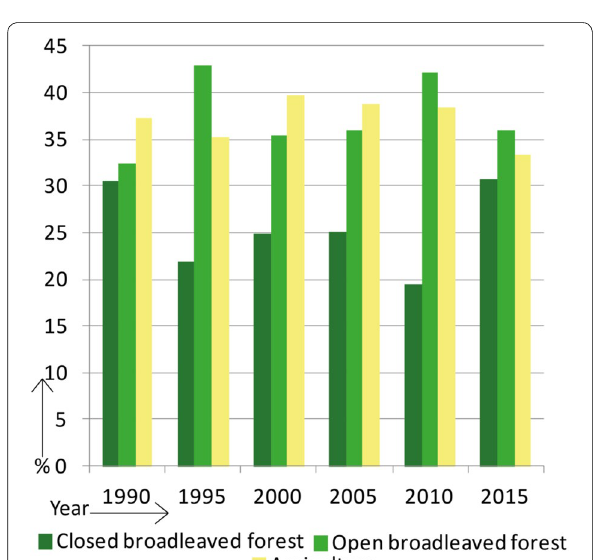
Fig. 8 Graph illustrating changes in various land cover for Gharmi– Bhoti